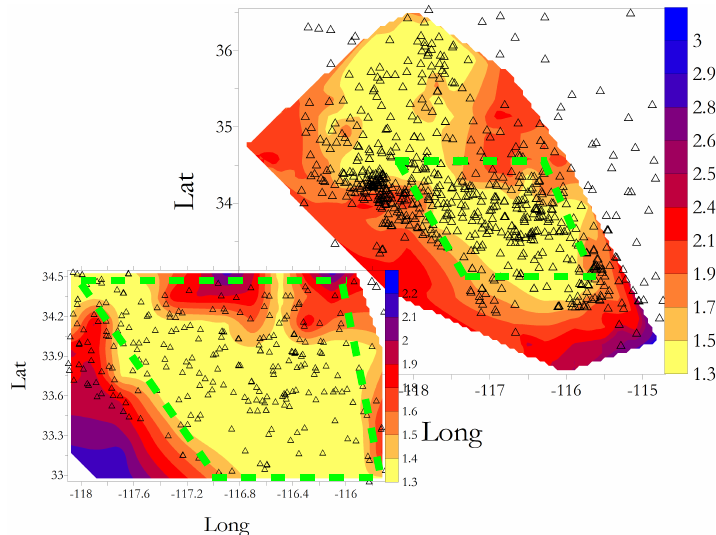
Figure 1. Magnitude completeness in Southern California. The value of m c can be obtained by the color bar and triangles identify the location of seismic stations. Green dashed lines define Region 1. Region 2 is the complement to Region 1 with respect to the entire Southern California (From